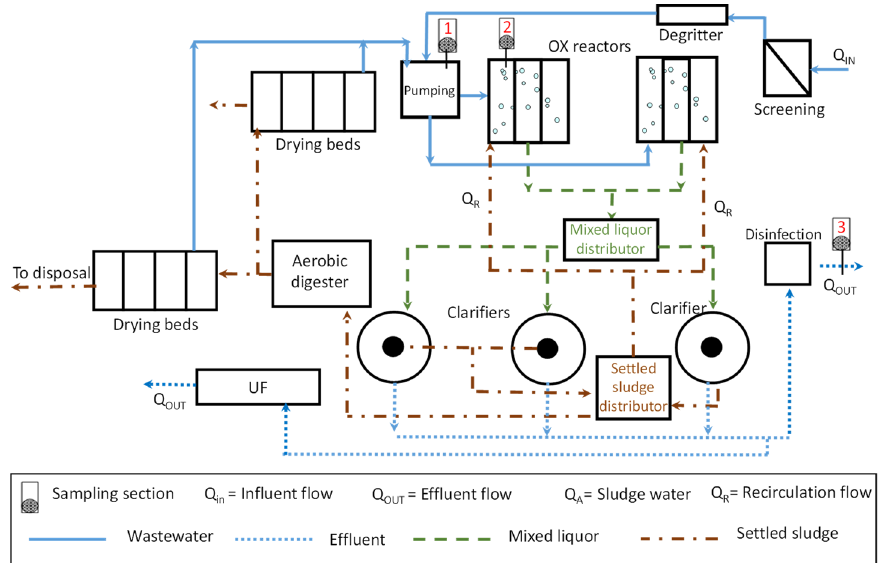
Figure 6. Schematic representation of the Marineo WWTP.